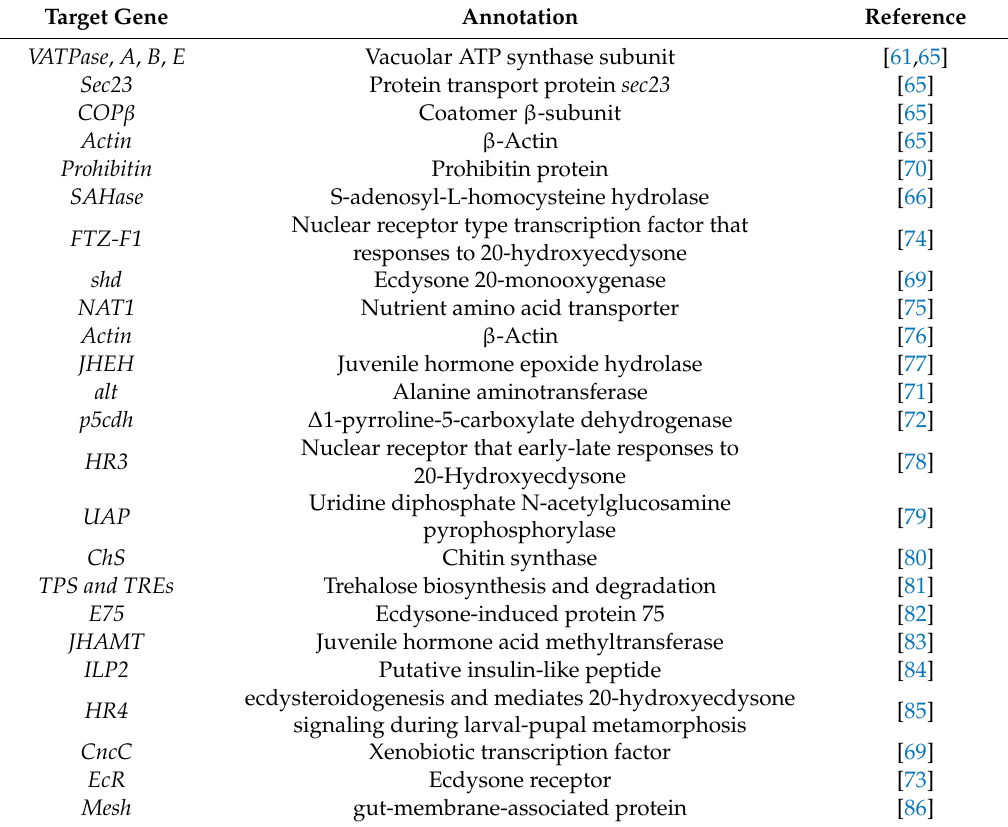
Table 1. Review of target genes for RNA interference (RNAi)-based Colorado potato beetle control (modified from He et al.